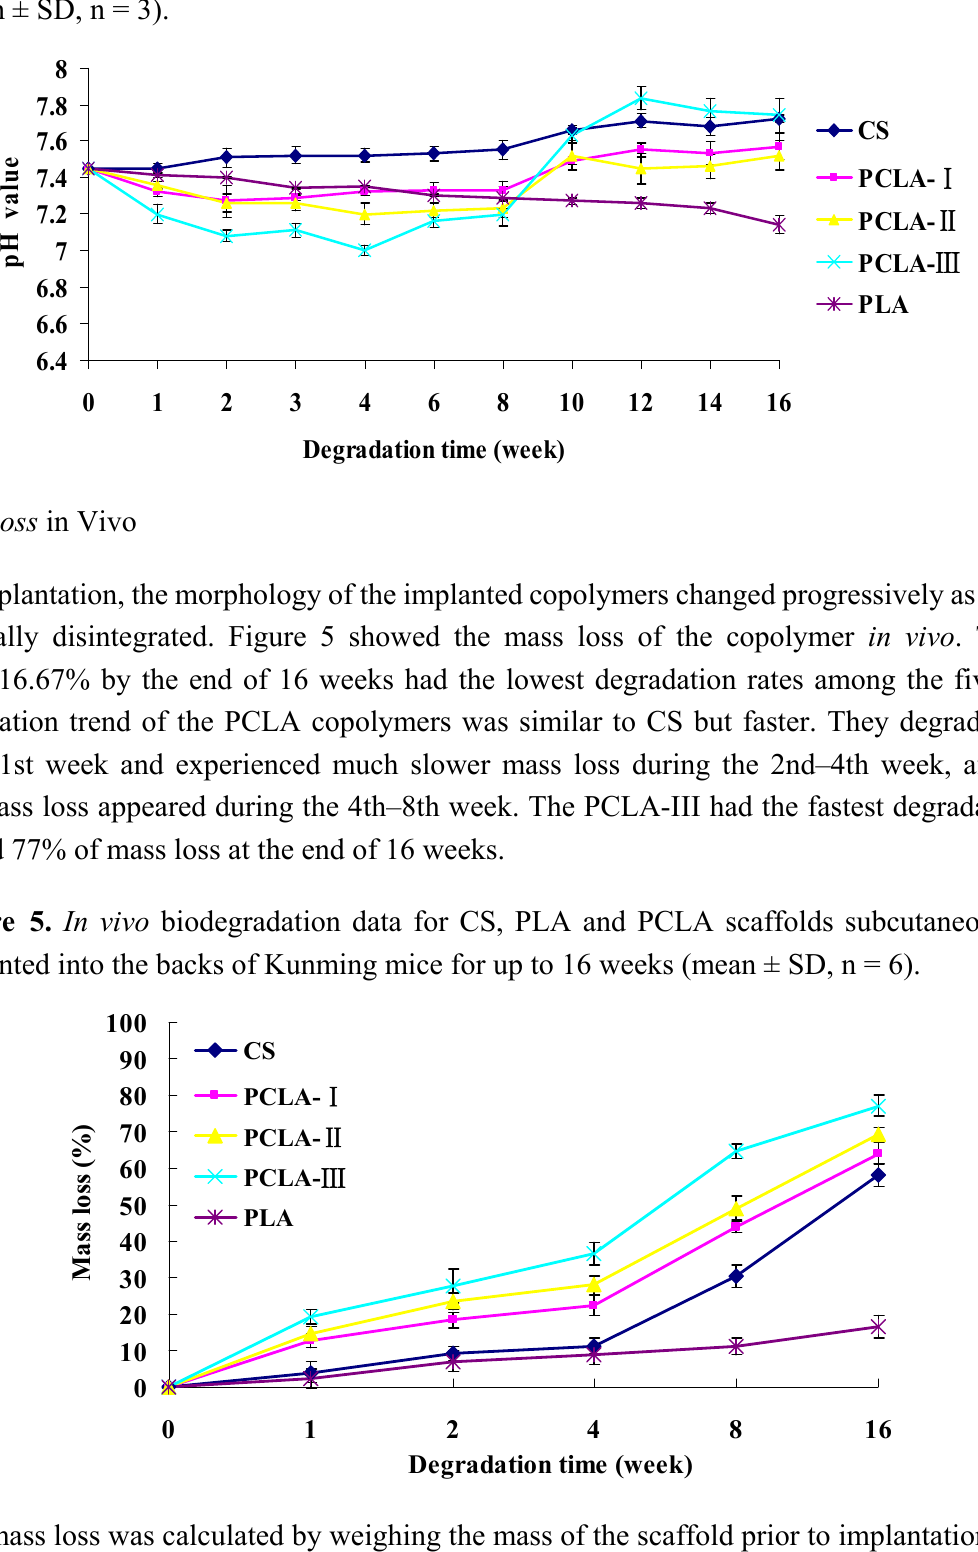
Figure 4. The pH value in PBS by sodium azide (0.01 wt %) at 37 °C for up to 16 weeks (mean ± SD, n = 3).